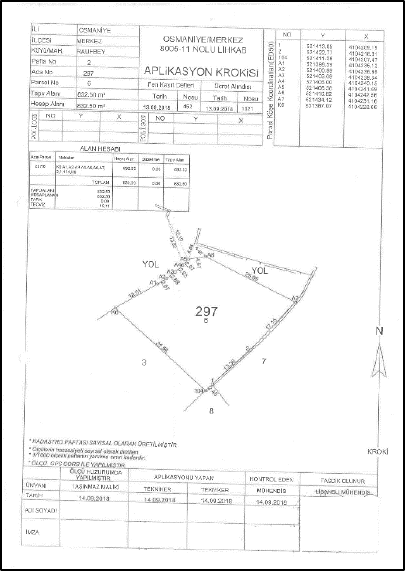
Figure 3. Plan of site (sample form Osmaniye, Turkey)